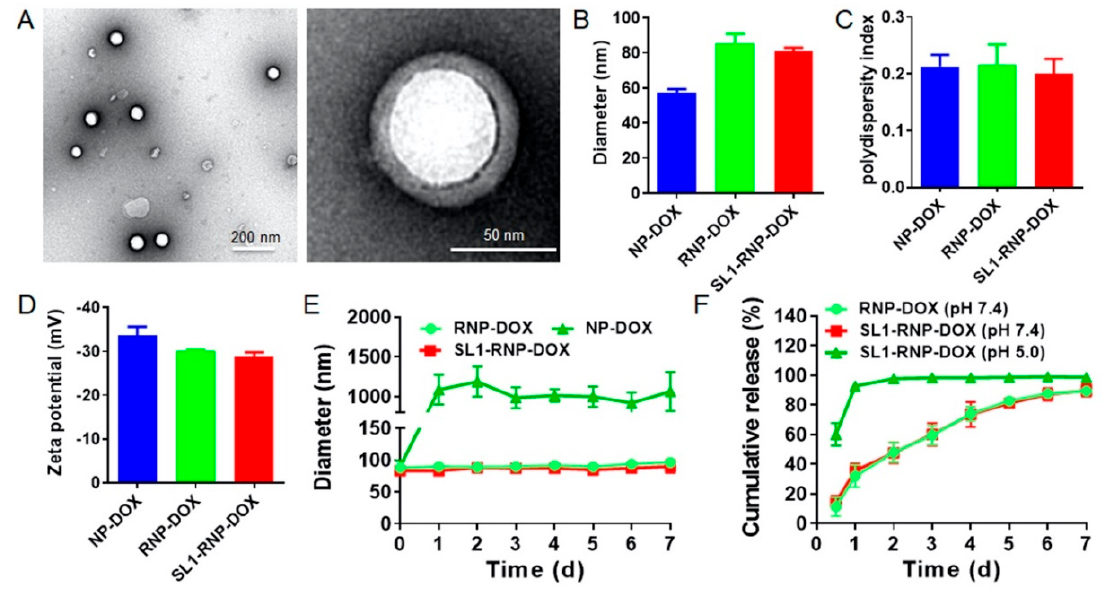
Figure 1. Characterization of SL1 − RNP − DOX ( n = 3). ( A ) TEM images of SL1 − RNP − DOX. ( B ) Average diameter, ( C ) polydispersity index, and ( D ) zeta potential of NP − DOX, RNP − DOX, and SL1 − RNP − DOX in water. ( E ) Size changes of NP − DOX, RNP − DOX, and SL1 − RNP − DOX suspended in 0.01 mol/L PBS and stored at 4 ◦ C for a week. ( F ) Cumulative release of DOX from RNP − DOX and SL1 − RNP − DOX in different